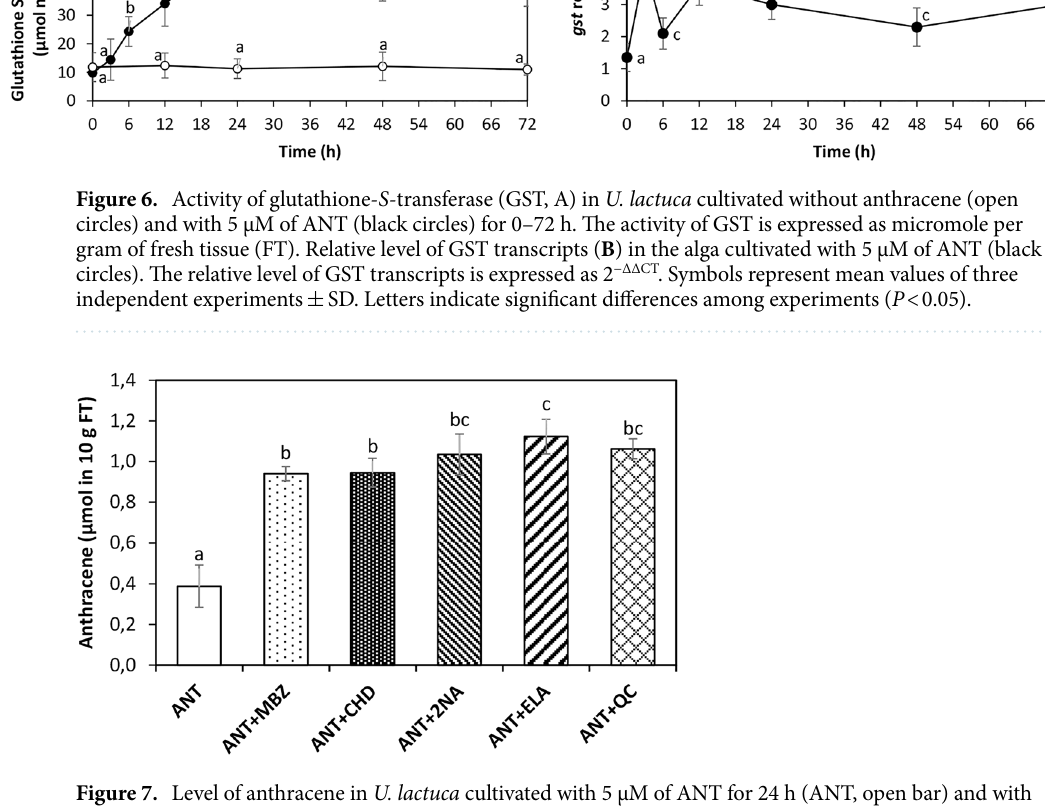
Figure 7. Level of anthracene in U. lactuca cultivated with 5 μM of ANT for 24 h (ANT, open bar) and with 0.5 μM of mebendazole (MBZ), an inhibitor of monooxygenases, cyclohexanedione (CHD), an inhibitor of dioxygenases, 2-naphtoic acid (2-NA), an inhibitor of polyphenol oxidases, ellagic acid (ELA), an inhibitor of GST, and quercetin (QC), an inhibitor of sulfotransferases, and with 5 µM of ANT for 24 h (dashed bars). The level of ANT is expressed as micromole in 10 g of algae fresh tissue (FT). Bars represent mean values of three independent experiments. Letters indicate significant differences among experiments ( P <